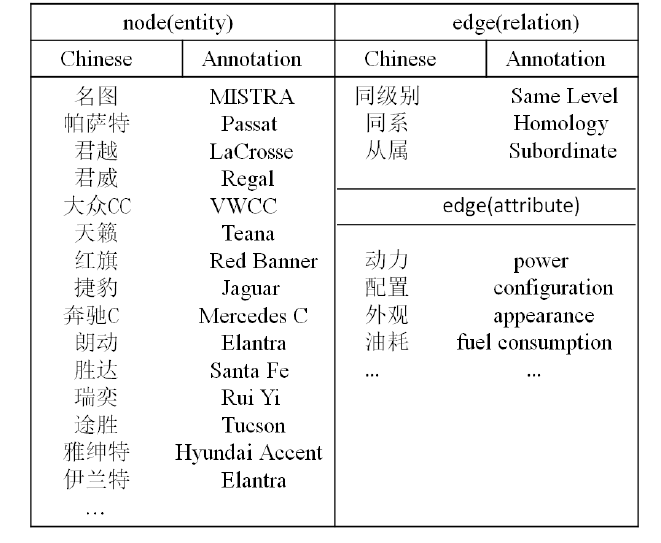
Figure 21. The partial annotations in the knowledge